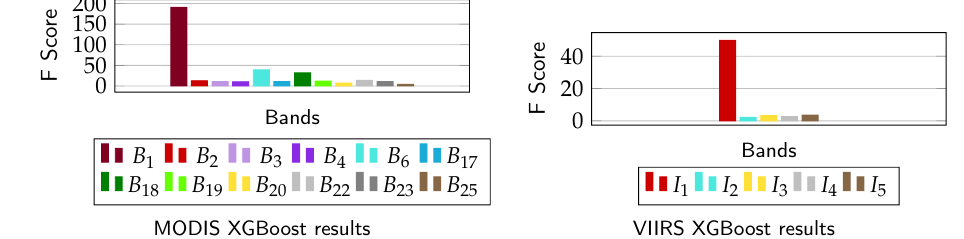
Figure 11. Bar graphs for MODIS (left) and VIIRS (right) showing the significance of each of the selected bands (12 for MODIS, 5 for VIIRS) for frozen vs. non-frozen pixel separation using the XGBoost algorithm [41]. All non-transition days from winter 16–17 are included in the analysis.